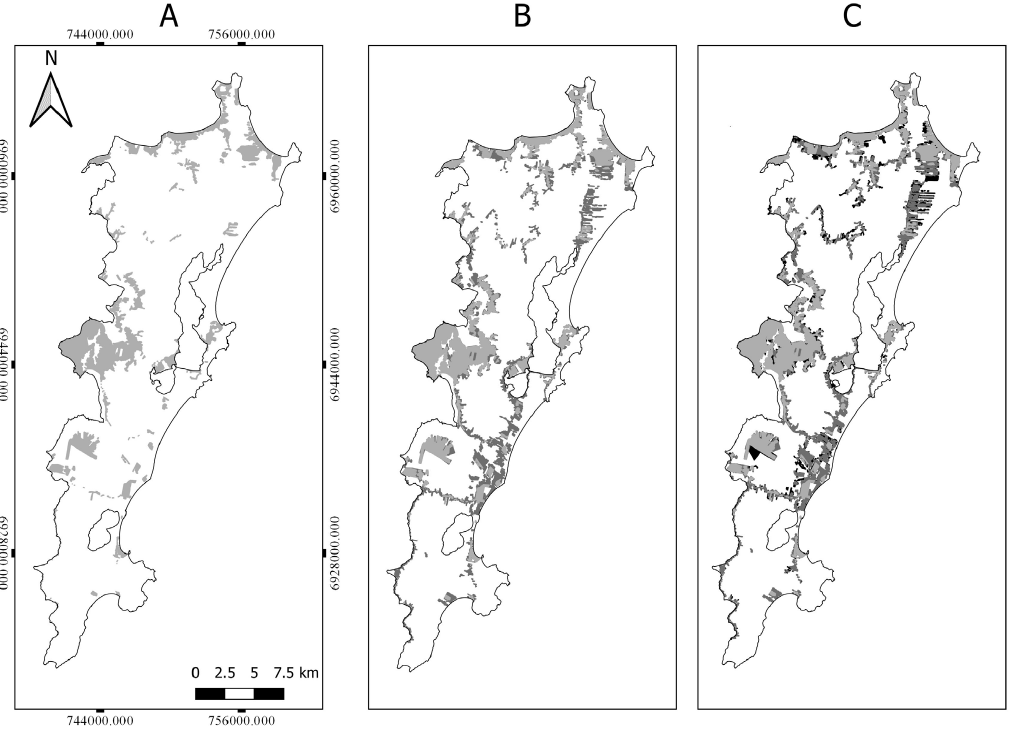
Figure 3. Urban evolution maps of Santa Catarina Island. The maps show the urbanized area of 8% in (A) 1993 (light grey); (B) urbanized area of 14% in 2003 (medium grey); and (C) urbanized area of 16% in 2013 (dark